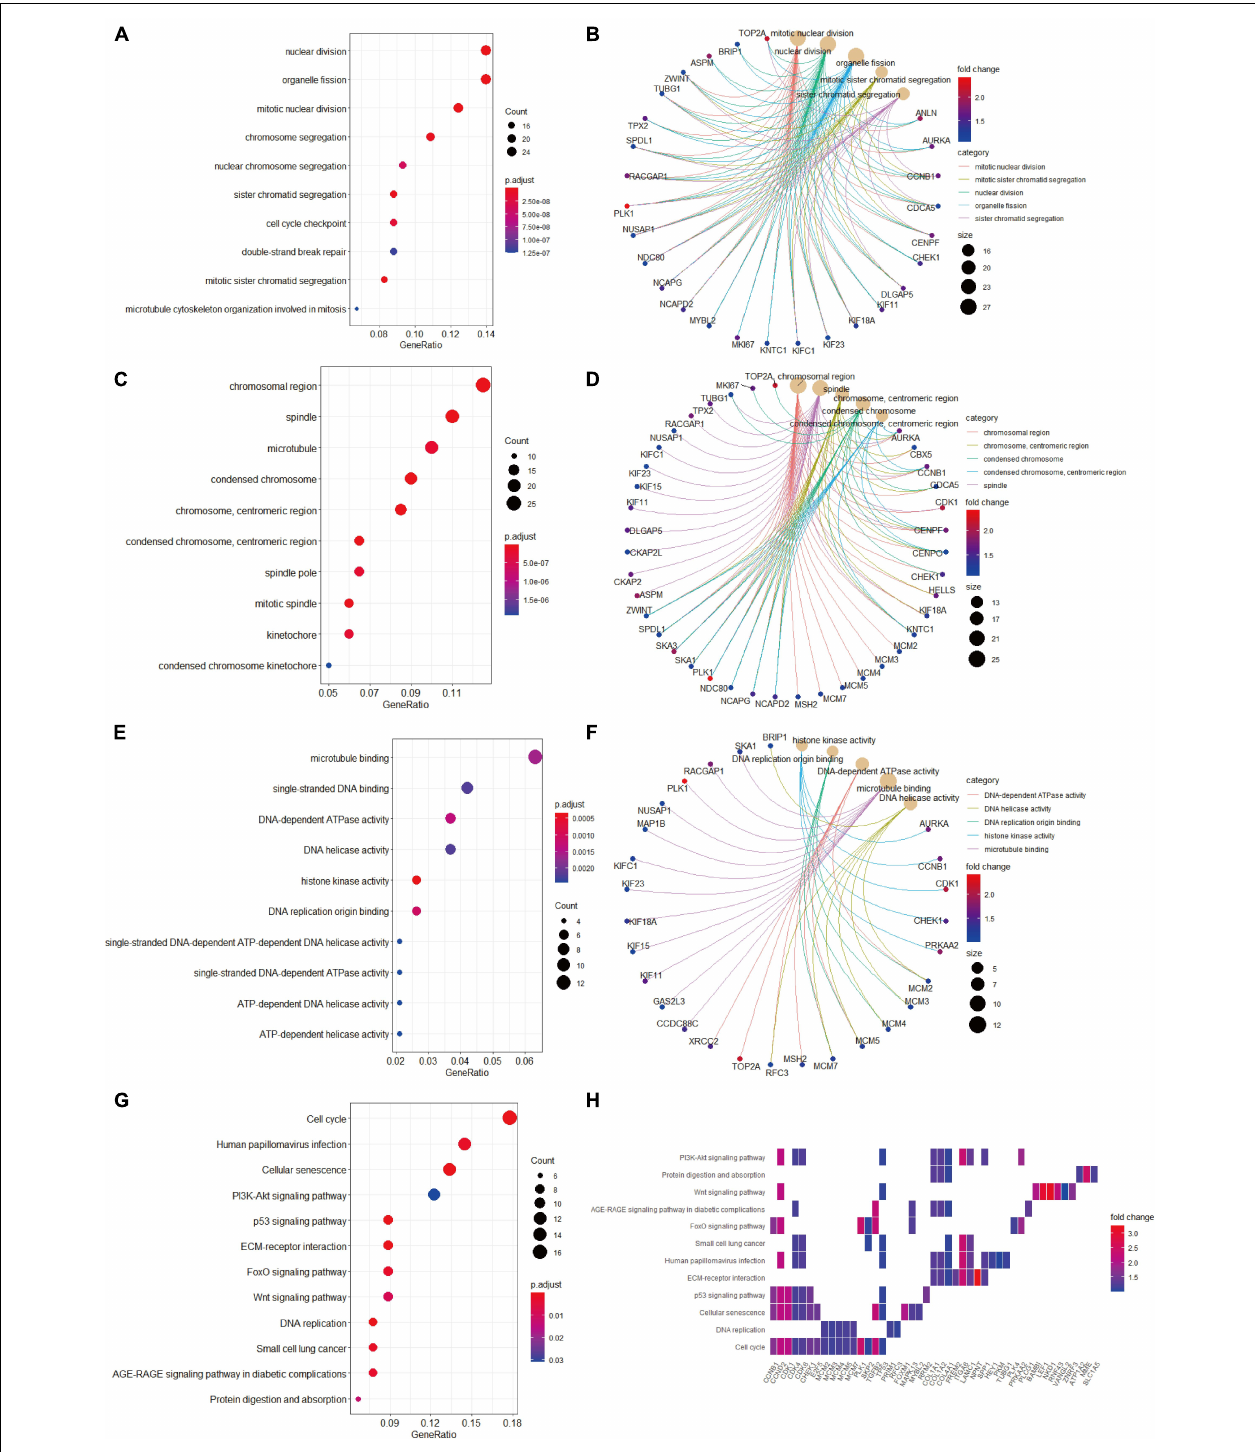
FIGURE 5 | Gene Ontology terms and KEGG pathway enrichment analyses of the upregulated candidate genes. (A) The enriched GO-BP terms based on upregulated candidate genes. (B) The upregulated candidate genes and their enriched GO-BP terms. (C) The enriched GO-CC terms based on upregulated candidate genes. (D) The upregulated candidate genes and their enriched GO-CC terms. (E) The enriched GO-MF terms based on upregulated candidate genes. (F) The upregulated candidate genes and their enriched GO-MF terms. (G) KEGG pathway analysis showing the enriched pathways based on upregulated candidate genes. (H) Heatmap showing specific upregulated candidate genes and their enriched pathways. BP, biological process; CC, cellular component; GO, Gene Ontology; KEGG, Kyoto Encyclopedia of Genes and Genomes; MF, molecular function.